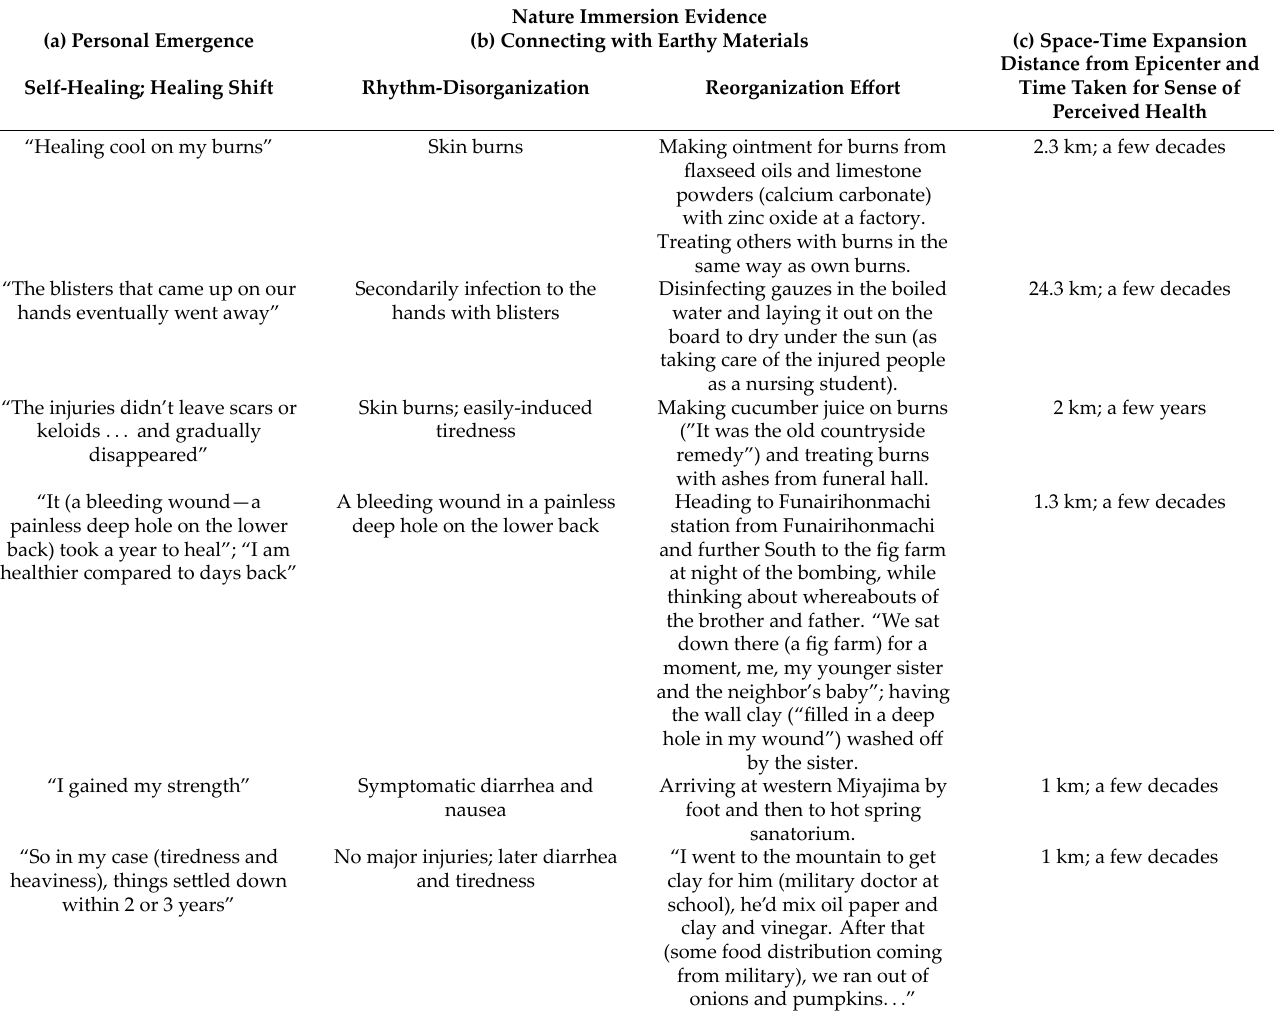
Table 3. A categorization matrix of nature immersion events of Hiroshima Atomic‑bombing